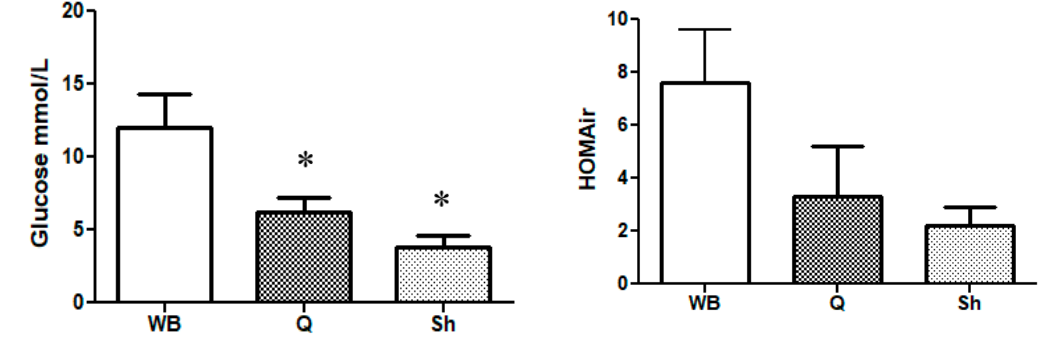
Figure 1. Glucose and HOMAir in mice fed with a high-fat diet and administered with the different bread formulations: WB, white bread; Q, quinoa flour (25%)-containing bread; Sh, chia flour (20%)- containing bread. * Indicates statistically significant ( p < 0.05) differences in relation to